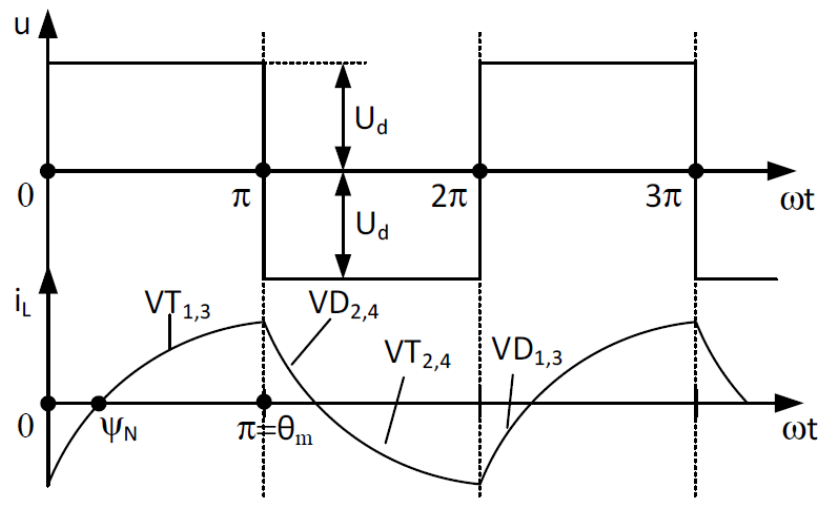
Figure 2. Timing diagrams describing the operation of a voltage source inverter.